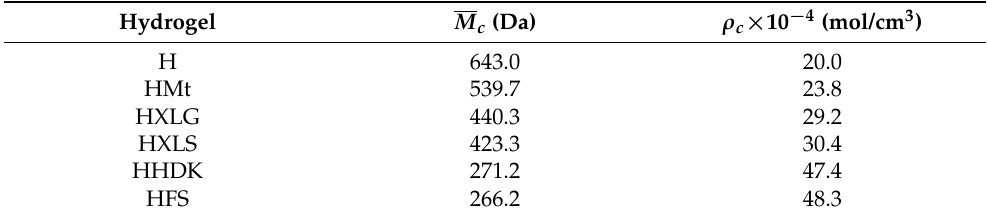
Table 3. Dependence of the structural parameters M c and ρ c of the composite hydrogels on the reinforcing agent at pH =